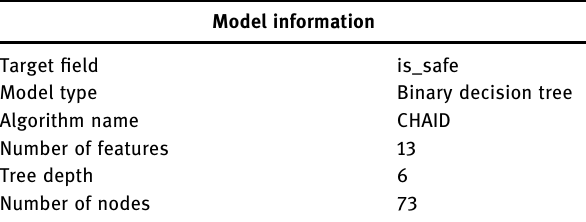
Table 3: CHAID model information for water quality prediction